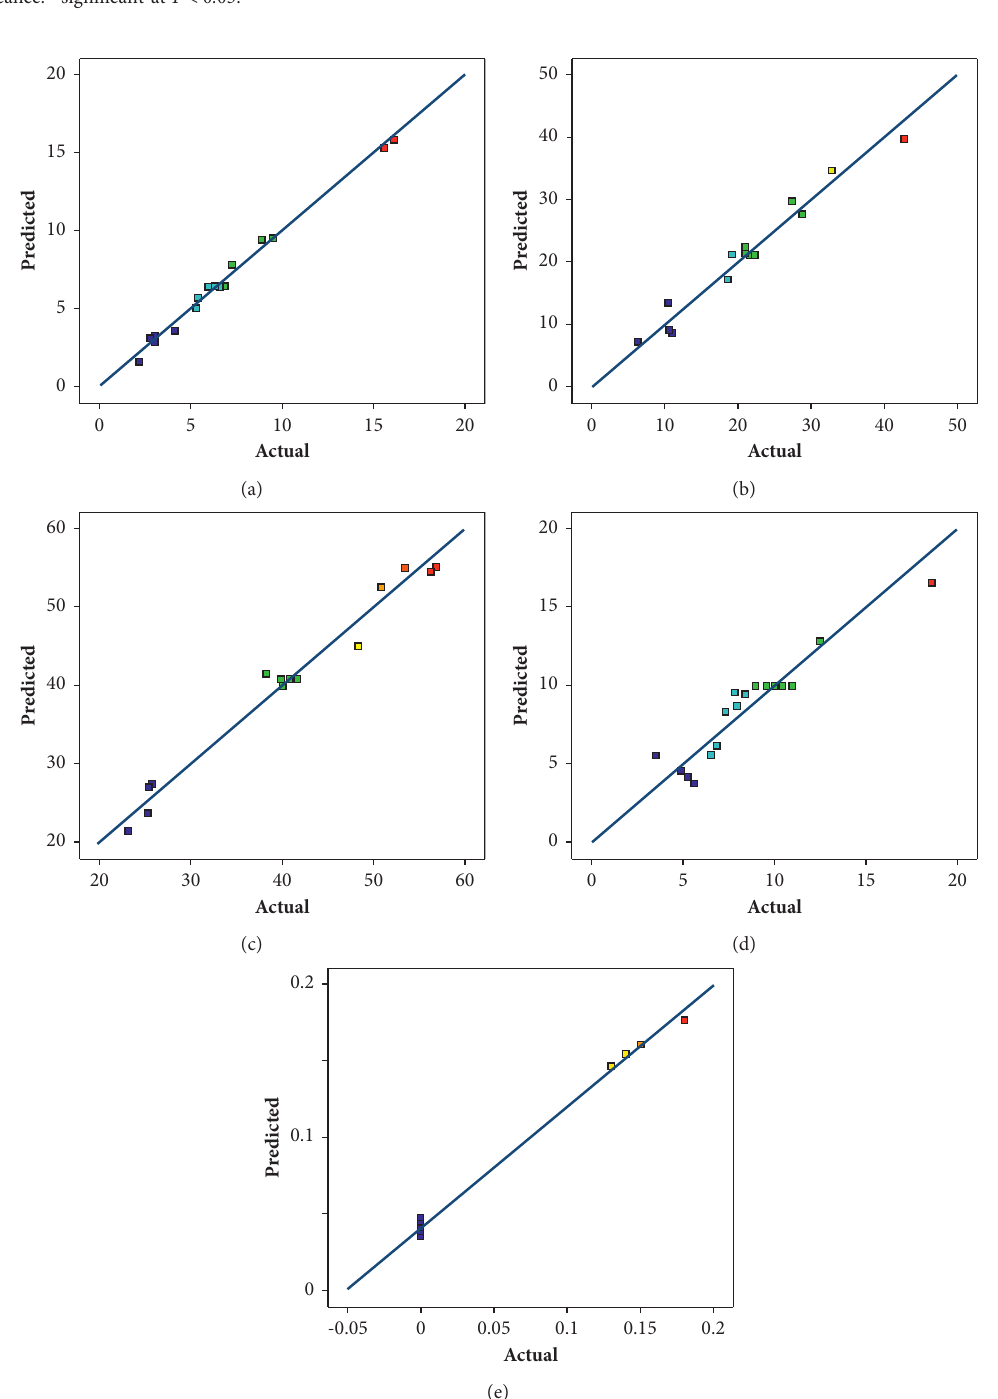
Figure 1: Plot of the relationship between the predicted value from the model and the observed or experimental value from the experiment in each response (I � percentage extraction yield, II � total flavonoid content, III � total phenolic content, IV � total carotenoid content, and V � total anthocyanin content).